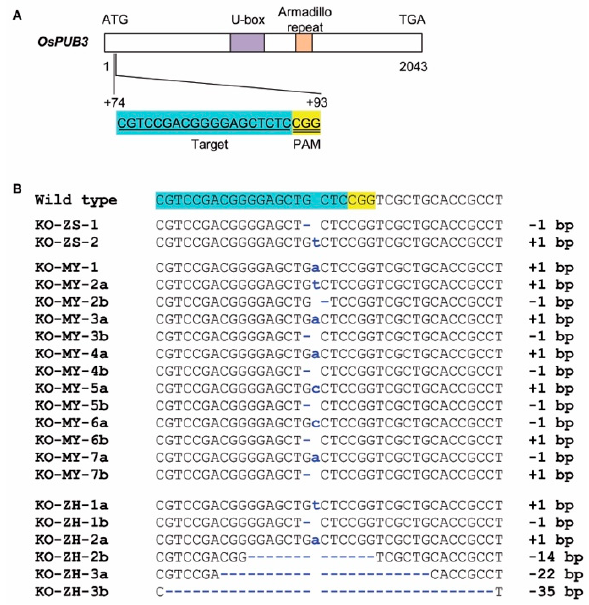
Figure 1. Knockout of OsPUB3 in three rice cultivars. ( A ) The schematic of OsPUB3 gene structure and the CRISPR/Cas9 target site. OsPUB3 has only one exon indicated by black rectangles. The translation initiation codon (ATG) and termination codon (TGA) are shown. OsPUB3 protein contains a U-box motif and an Armadillo repeat. ( B ) Sequence mutations in the target region. Mutations are indicated by blue letters. KO-ZS-1 and KO-ZS-2 were two homozygous mutants in the NIL ZS97 background. KO-MY-1 was a homozygous mutant in the NIL MY46 background; KO-MY-2 to KO-MY-7 were six biallelic mutants in the NIL MY46 background. KO-ZH-1, KO-ZH-2 and KO-ZH-3 were three biallelic mutants in the ZH161 background.